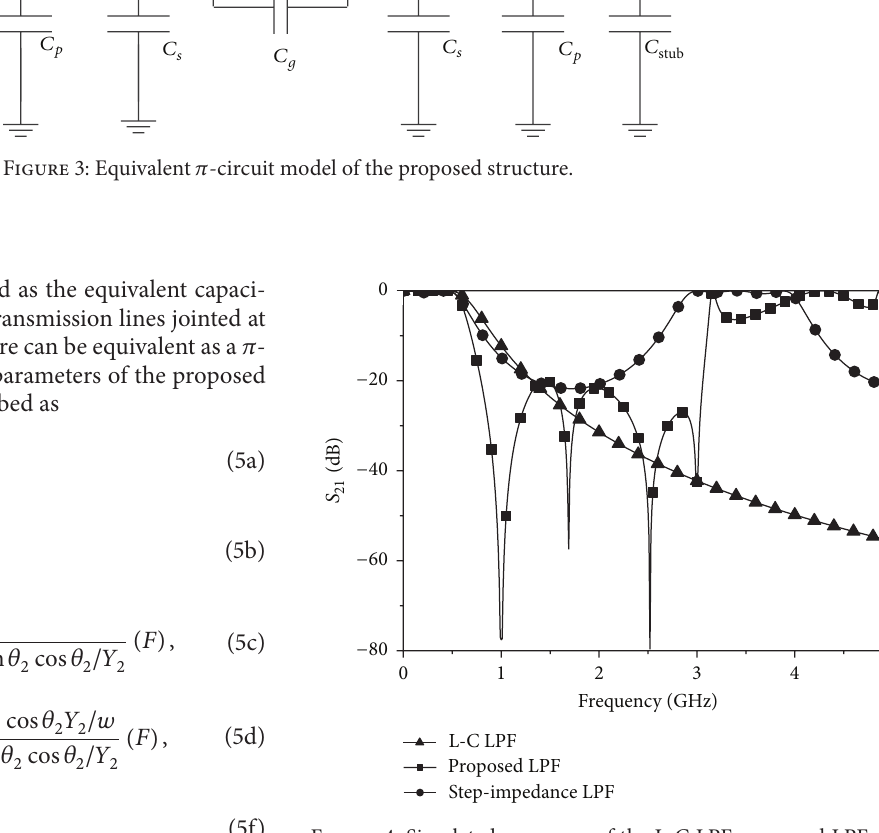
Figure 4: Simulated responses of the L-C LPF, proposed LPF, and the step-impedance